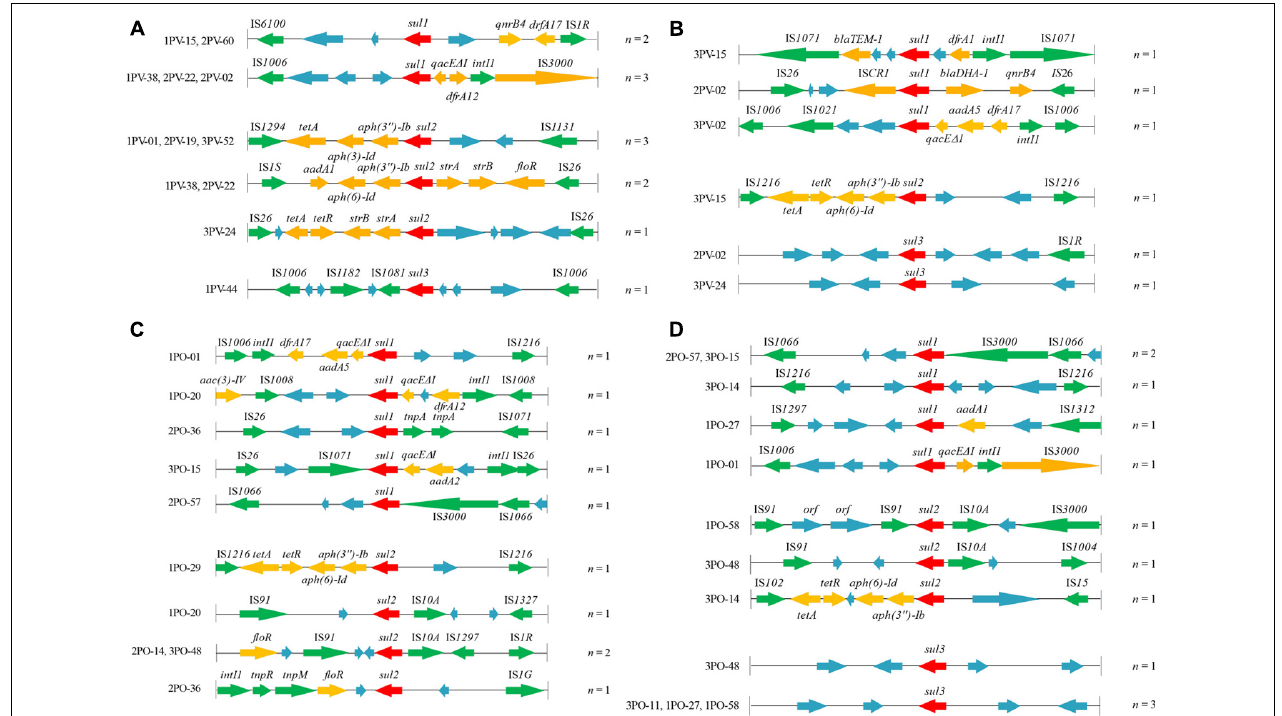
FIGURE 2 | Genetic organization of sul gene-associated regions in (A) plasmids of 12 sul -positive Escherichia coli isolates from Penaeus vannamei ; (B) chromosomes of 12 sul -positive E. coli isolates from P. vannamei ; (C) plasmids of 12 sul -positive E. coli isolates from pork products; and (D) chromosomes of 12 sul -positive E. coli isolates from pork products presented with their isolate numbers. The orientation of each gene and insertion element is indicated by arrows. The same units are shown in the same color. The same functional units or unknown functional units are shown in the same color (red, sul genes; yellow, antibiotic resistance genes other than sul genes; green, mobile genetic elements; blue, unknown functional unit). Names of sequence units are indicated above or below the arrows, and sequence units with unknown functions have been left blank.